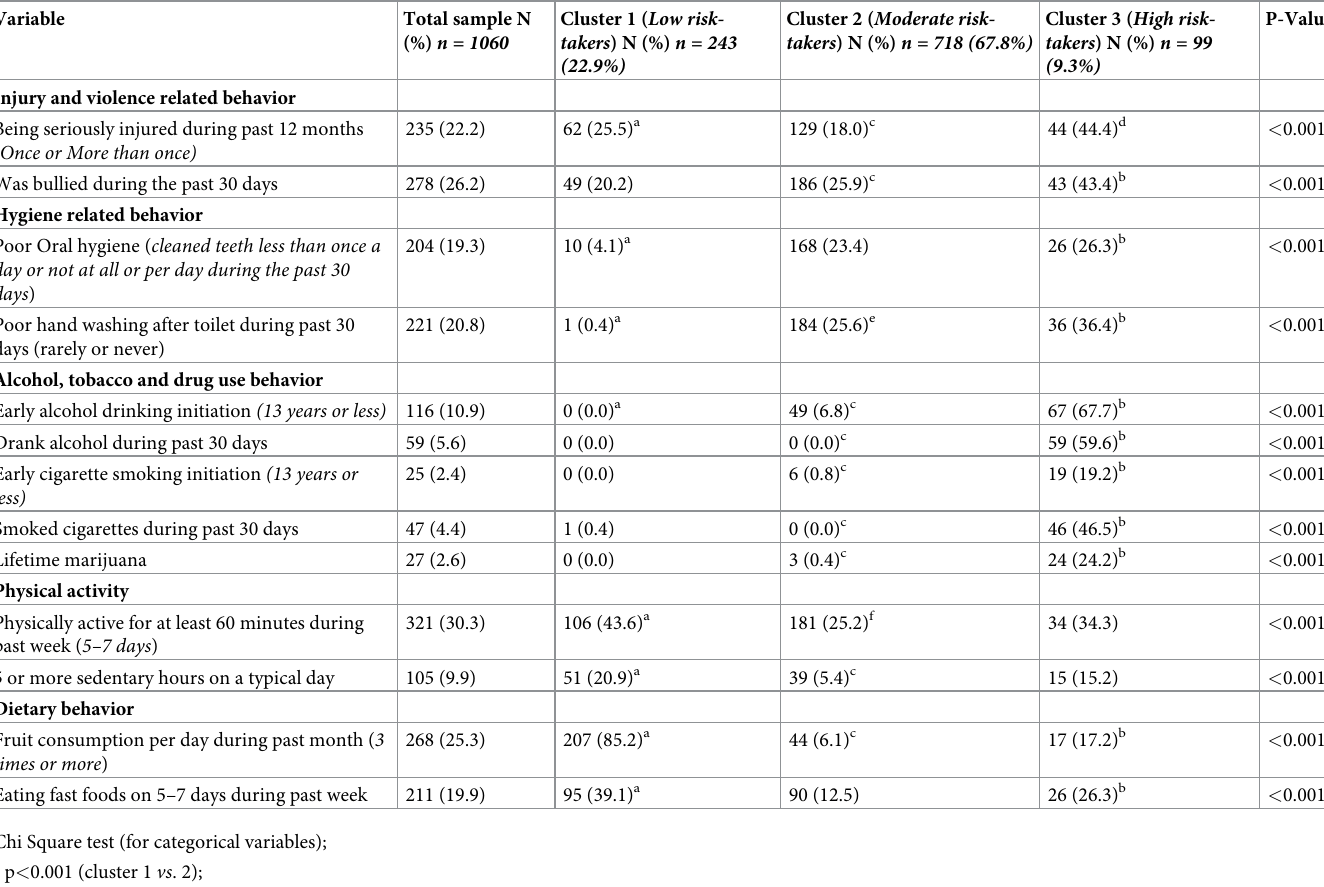
Table 2. A comparison of behavioral characteristics across the 3 behavioral clusters.